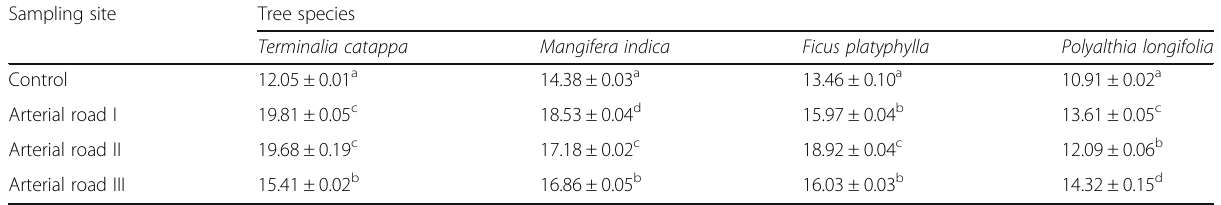
Table 6 The effect of vehicular air pollution on ascorbic acid contents (mg/g) of selected tree species in the Kumasi Metropolis Sampling